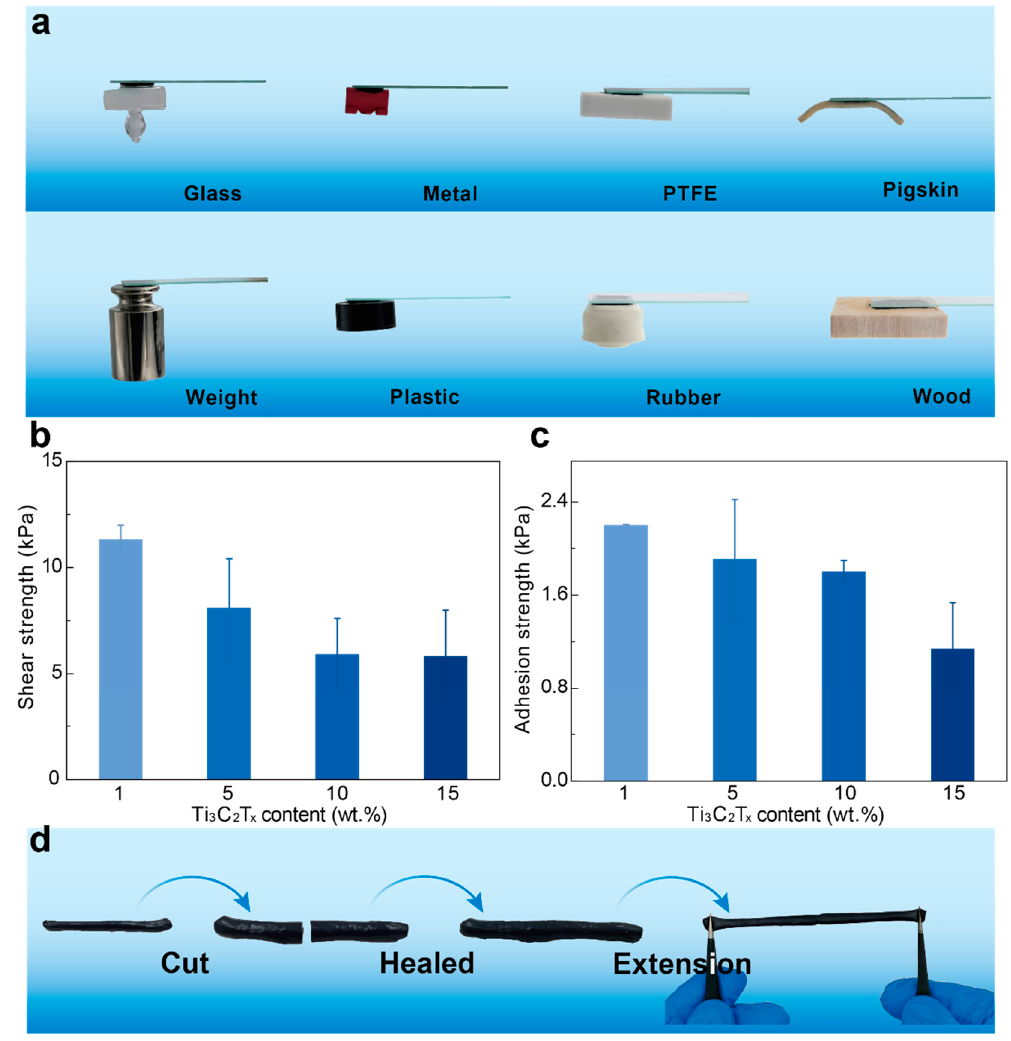
Figure 4. Adhesion property and self-healing property of Ti 3 C 2 T x -PAA hydrogels. ( a ) Photographs illustrate the adhesion ability of hydrogels on different substrates (glass, metal, PTFE, weight, rubber, plastic, wood and pigskin). ( b ) Shear adhesion strength of Ti 3 C 2 T x -PAA hydrogels on PET substrates. ( c ) Adhesion strength on aluminum substrate. ( d ) Self-healing property of the hydrogel. Additionally, we measure the adhesion strength on aluminum substrate via 90 ◦ peeling and adhesion of hydrogels on PET by the lap shear test. In general, the electrostatic force between carboxyl groups on PAA chains and various substrates is the main reason for the adhesion of hydrogels [36]. In our work, the shear strength (5.84 kPa to 11.32 kPa)